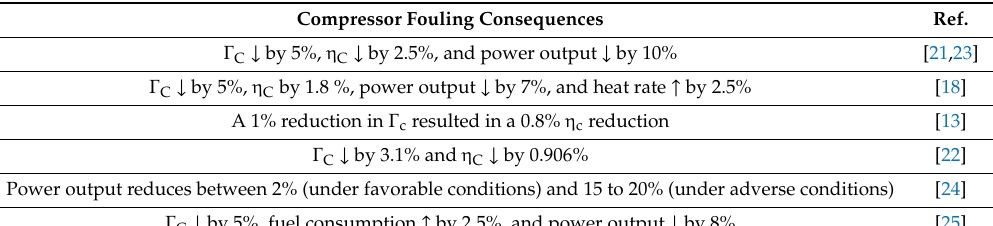
Table 1. Compressor fouling and its consequences according to di ff erent